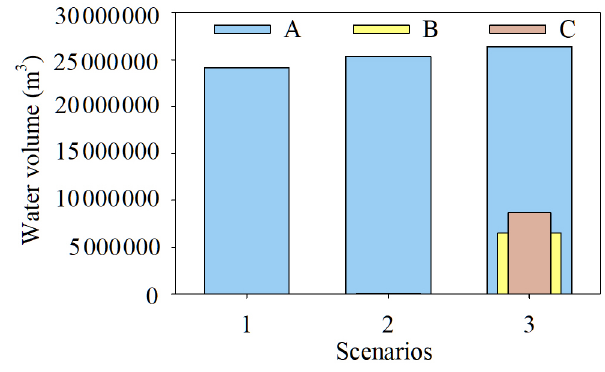
Figure 9. Discharge of waterbodies in glacial lakes under different